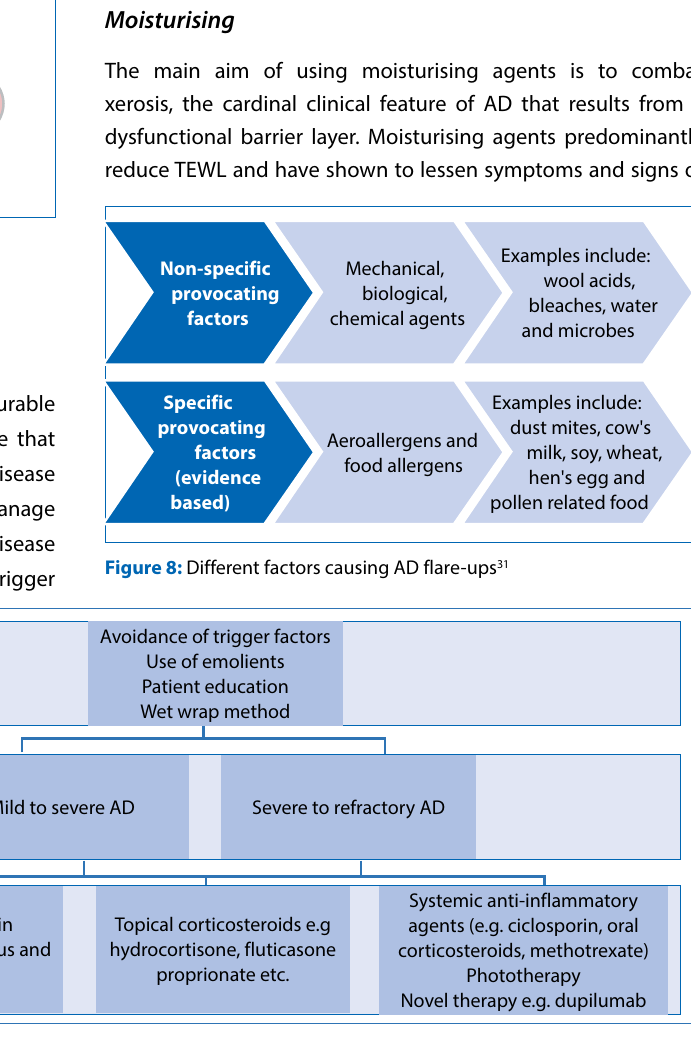
Figure 7: A summary of major management options for AD